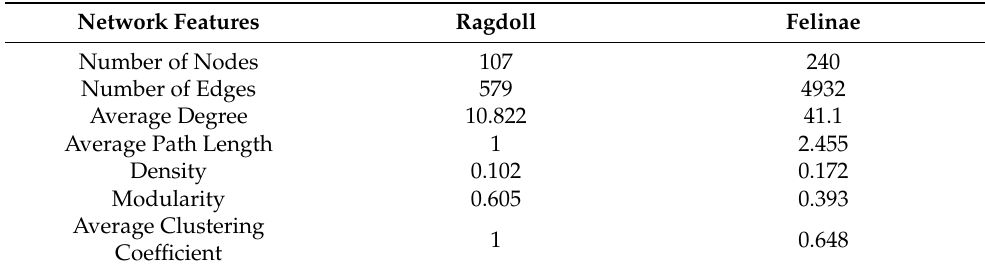
Table 4. The topological properties for the co-occurrence